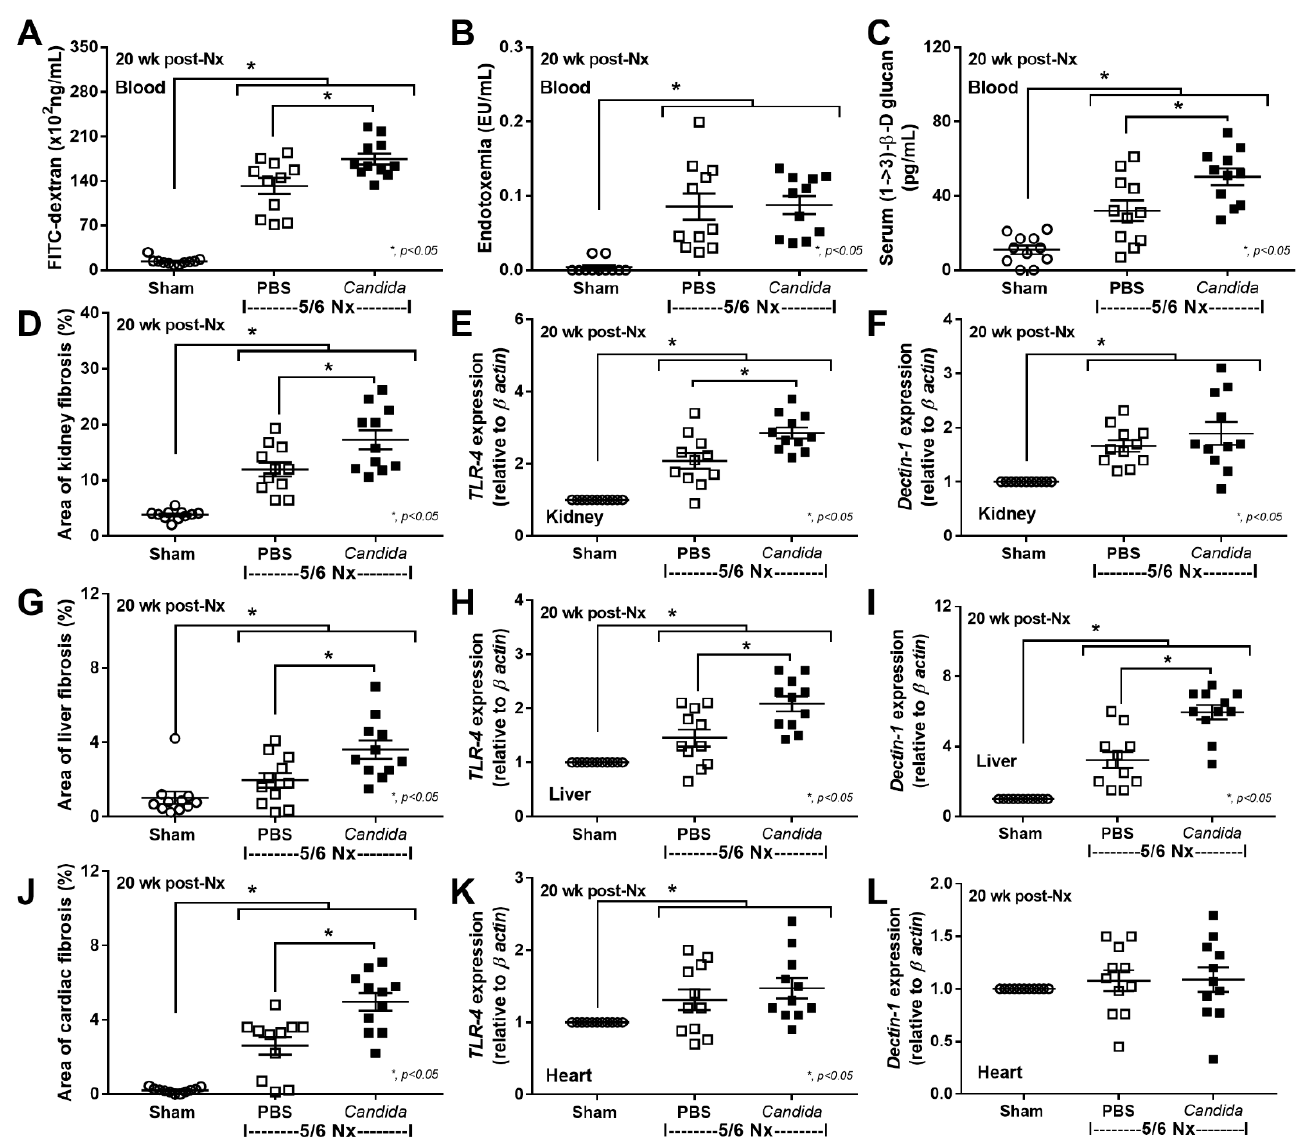
Figure 2. The characteristics of Sham control and 5/6 nephrectomized (5/6 Nx) mice with phosphate buffer solution (PBS) or Candida administration ( Candida ) at 20 weeks (wk) after right nephrectomy (20 week post Nx) (see method), as indicated by the gut barrier defect; FITC-dextran assay, endo- toxemia, and serum (1 → 3)- β -D-glucan (BG) ( A – C ), area of organ fibrosis with the gene expression of Toll-like receptor 4 (TLR-4) and Dectin-1 in the kidney ( D – F ), liver ( G – I ), and heart ( J – L ) are demonstrated ( n = 11 / group).